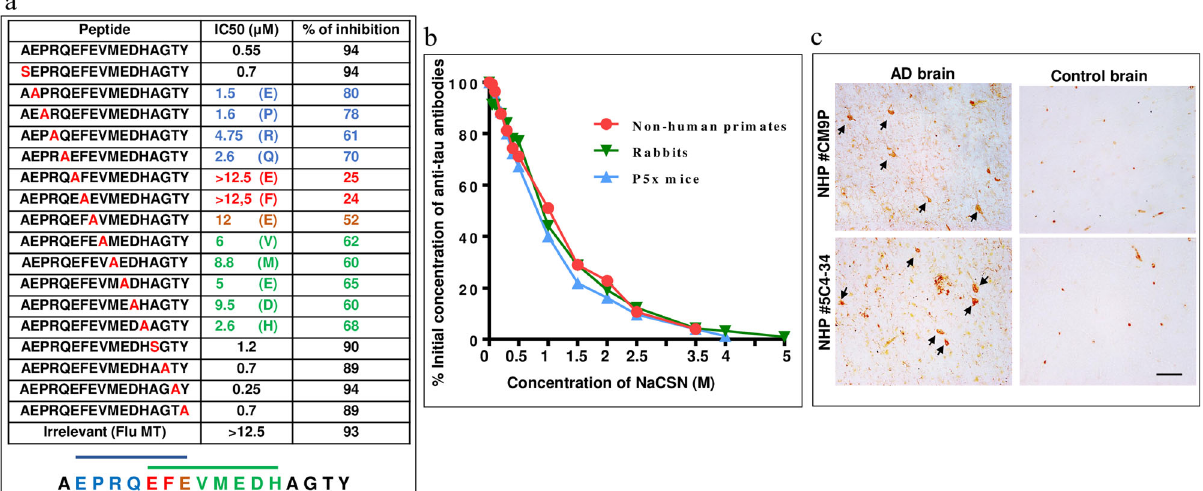
Fig. 6 Characterization of antibodies induced by vaccination with AV-1980R/A in NHP. a Epitope mapping of immune sera from vaccinated Macaca fascicularis was performed by alanine scanning competition ELISA. Two overlapped epitopes have been detected comprising amino acids 3 – 9 EPRQEFE and amino acids 7 – 14 EFEVMEDH. IC 50 and the percent of inhibition of antibody binding to Tau 2 – 18 peptide with mutated peptides (alanine substitution of each single amino acid) is shown in the table. b Relative avidity for binding with Tau protein in mice, rabbits, and monkeys was determined by Sodium thiocyanate displacement ELISA using puri fi ed antibodies from pooled sera of individual animals. The effective concentration of NaSCN required to release 50% of primary antibodies from the ELISA plate (half-maximal effective dose (ED 50 ) was 0.8 M for mice, 0.9 M for rabbits, and 1 M for NHP. The concentration of antibodies was adjusted to 30 ng/ml. c Immune sera, but not pre- bleed sera bound to neuro fi brillary tangles (NFT) in brain sections from the AD case. Sera were diluted at 1:1000. The original magni fi cation is 40X, and the scale bar is 20 μ m. Arrows show